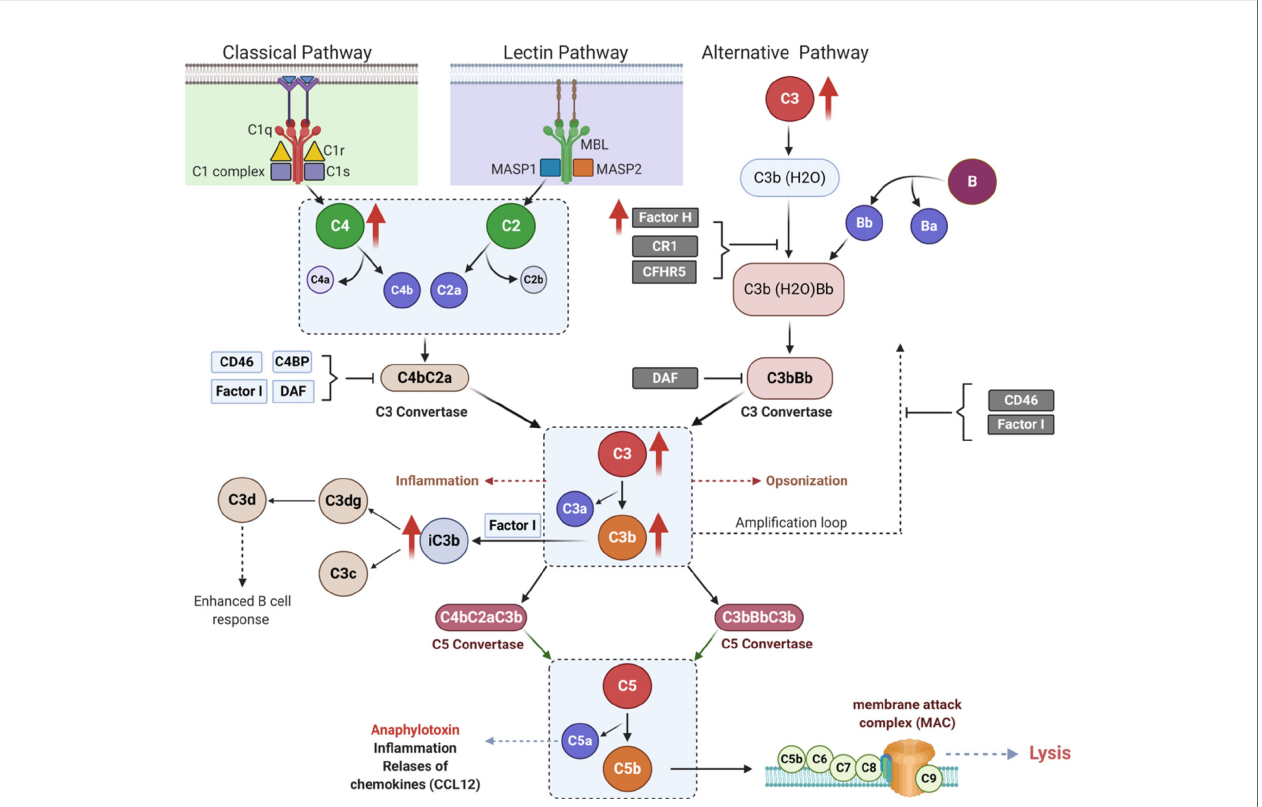
FIGURE 1 | Complement activation pathways. Schematic illustration of classical (left panel), lectin (middle panel), and alternative (right panel) pathways of complement activation, showing links between initiator molecules, proteases and C3, C5 convertases. Upward red arrows indicate the complements that are elevated in the second trimester of pregnancy in gestational diabetes